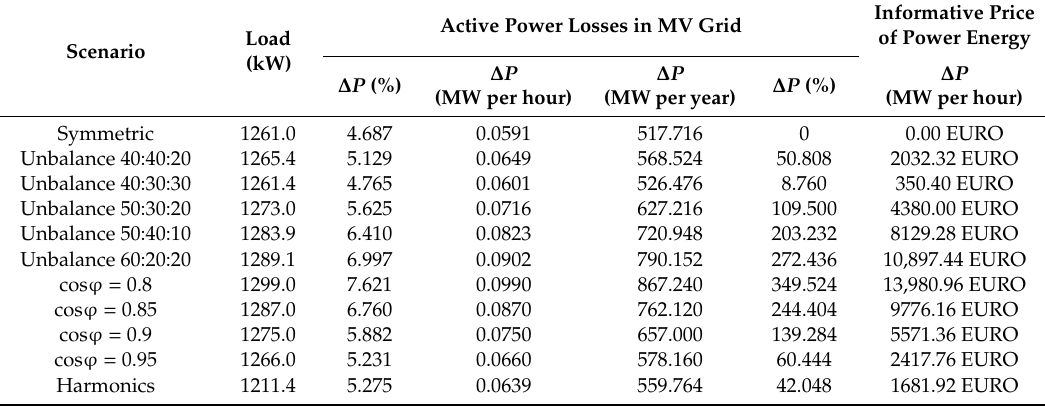
Table 6. Overview of active power losses and their impact on finance (ACSR 70 / 11, length of 40